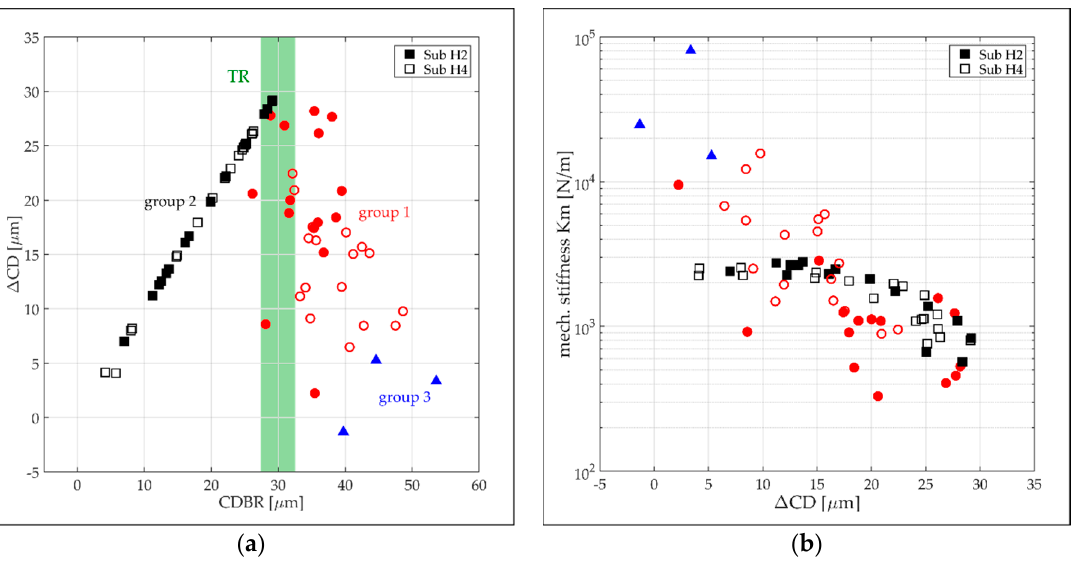
Figure 11. ( a ) Release induced change of the diaphragms’ CD ( Δ CD) as a function of the correspond- ing CD value before the release process (CDBR). Considered are again data of the diaphragms on substrate H2 (filled markers) and H4 (empty markers). The data are color-coded depending on the diaphragm group. The green shaded area represents the transition region between group 1 and 2 diaphragms; ( b ) mechanical diaphragm stiffness plotted versus Δ CD.